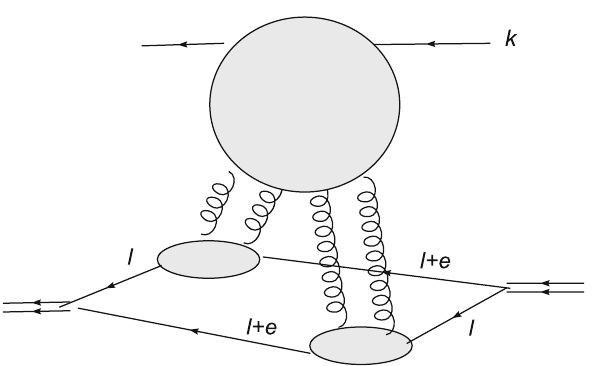
Fig. 3 Triple cut of the triple-pomeron